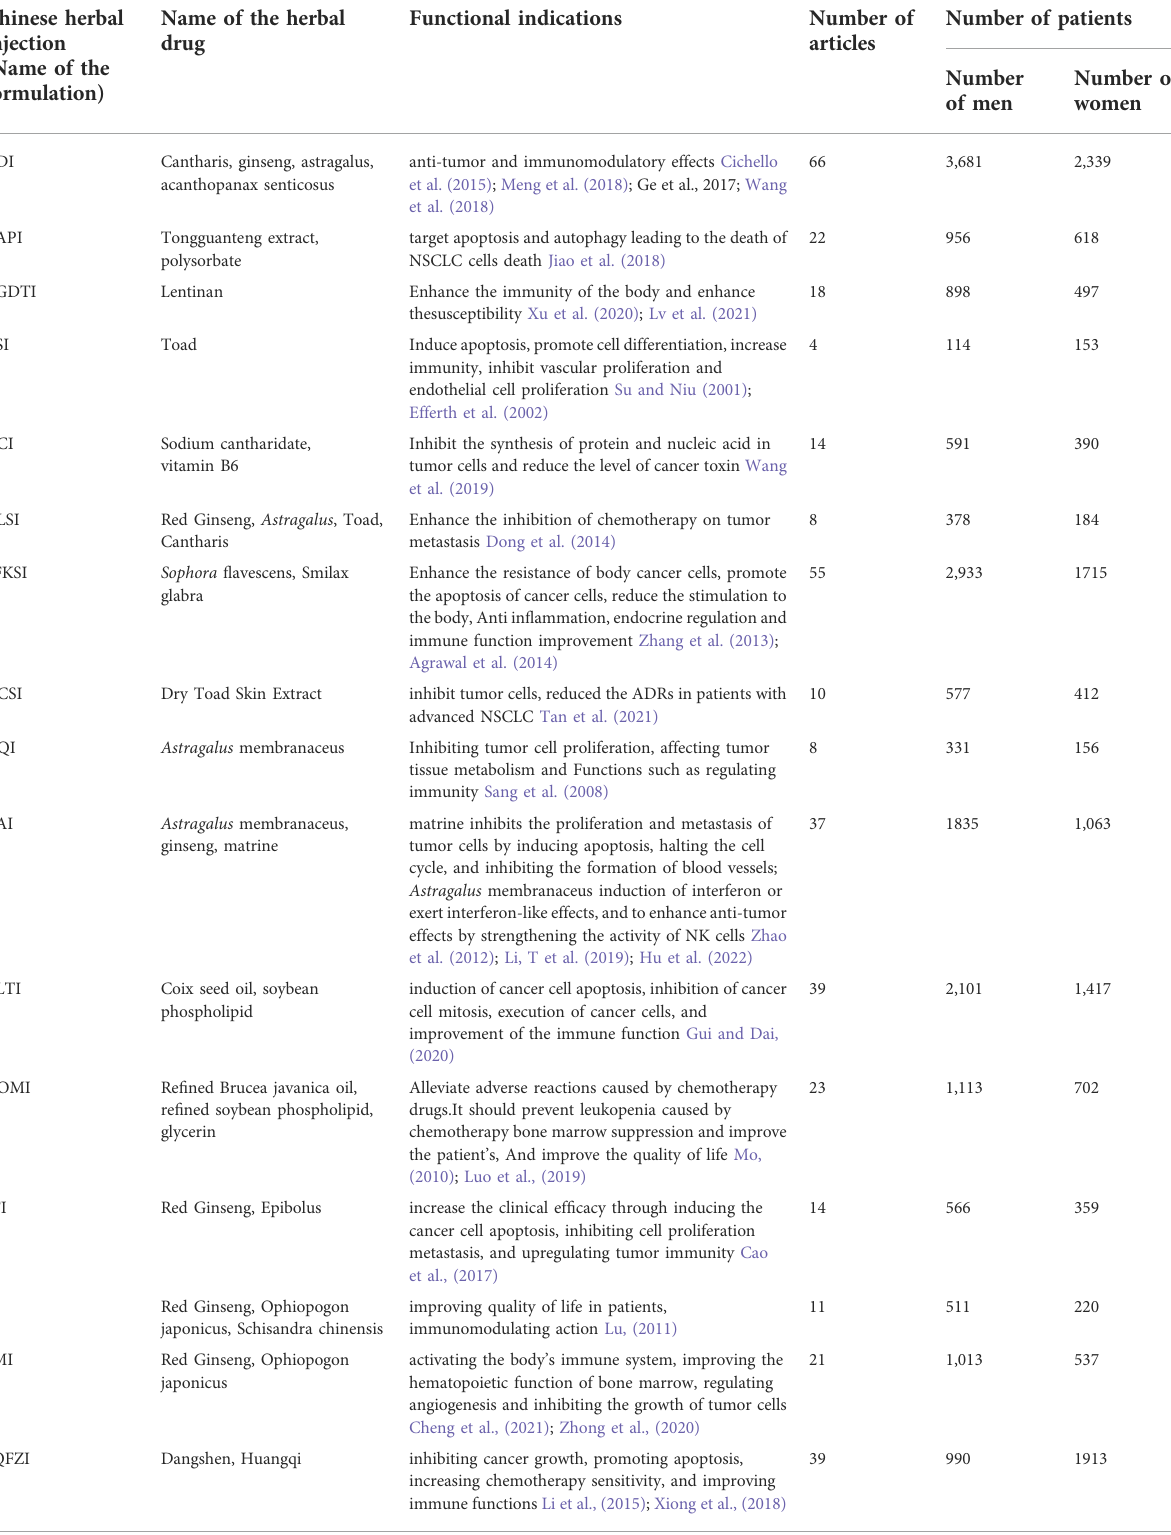
TABLE 2 Detailed information on Chinese herbal injections. Chinese herbal